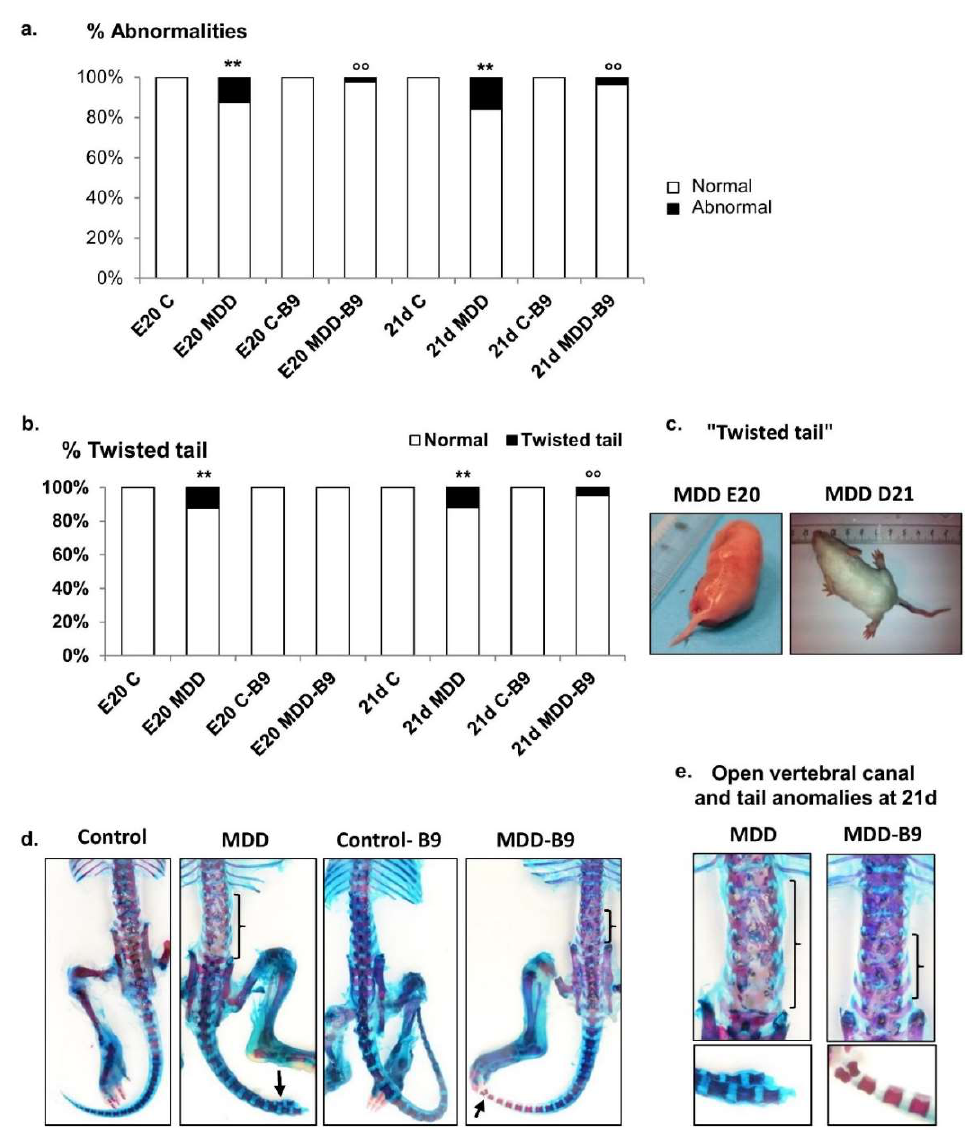
Figure 3. Effects of maternal methyl donor deficiency and folic acid supplementation on developmental abnormalities in the progeny. ( a ) Occurrence of developmental abnormalities in control and MDD fetuses at embryonic day 20 (E20) and at postnatal day 21 (21 d), and following folic acid (B9) supplementation (20 ≤ n ≤ 40). Statistically significant differences between control and MDD rats: ** p < 0.01, between MDD and supplemented MDD: ◦◦ p < 0.01; ( b ) Prevalence of “twisted tail” in controls, MMD and supplemented rats; ( c ) Illustration of MDD-associated “twisted tail” at E20 and postnatal day 21; ( d , e ) Photographs of the vertebral canal and tail (Alcian blue/Alizarin red staining) in the various experimental groups at 21 days (square brackets delineate open canal).